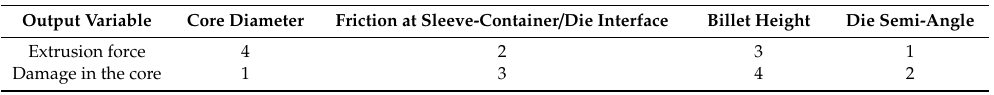
Table 16. Classification 1 of most influential parameters in extrusion of bimetallic parts (AZ31B core and Ti6Al4V sleeve).